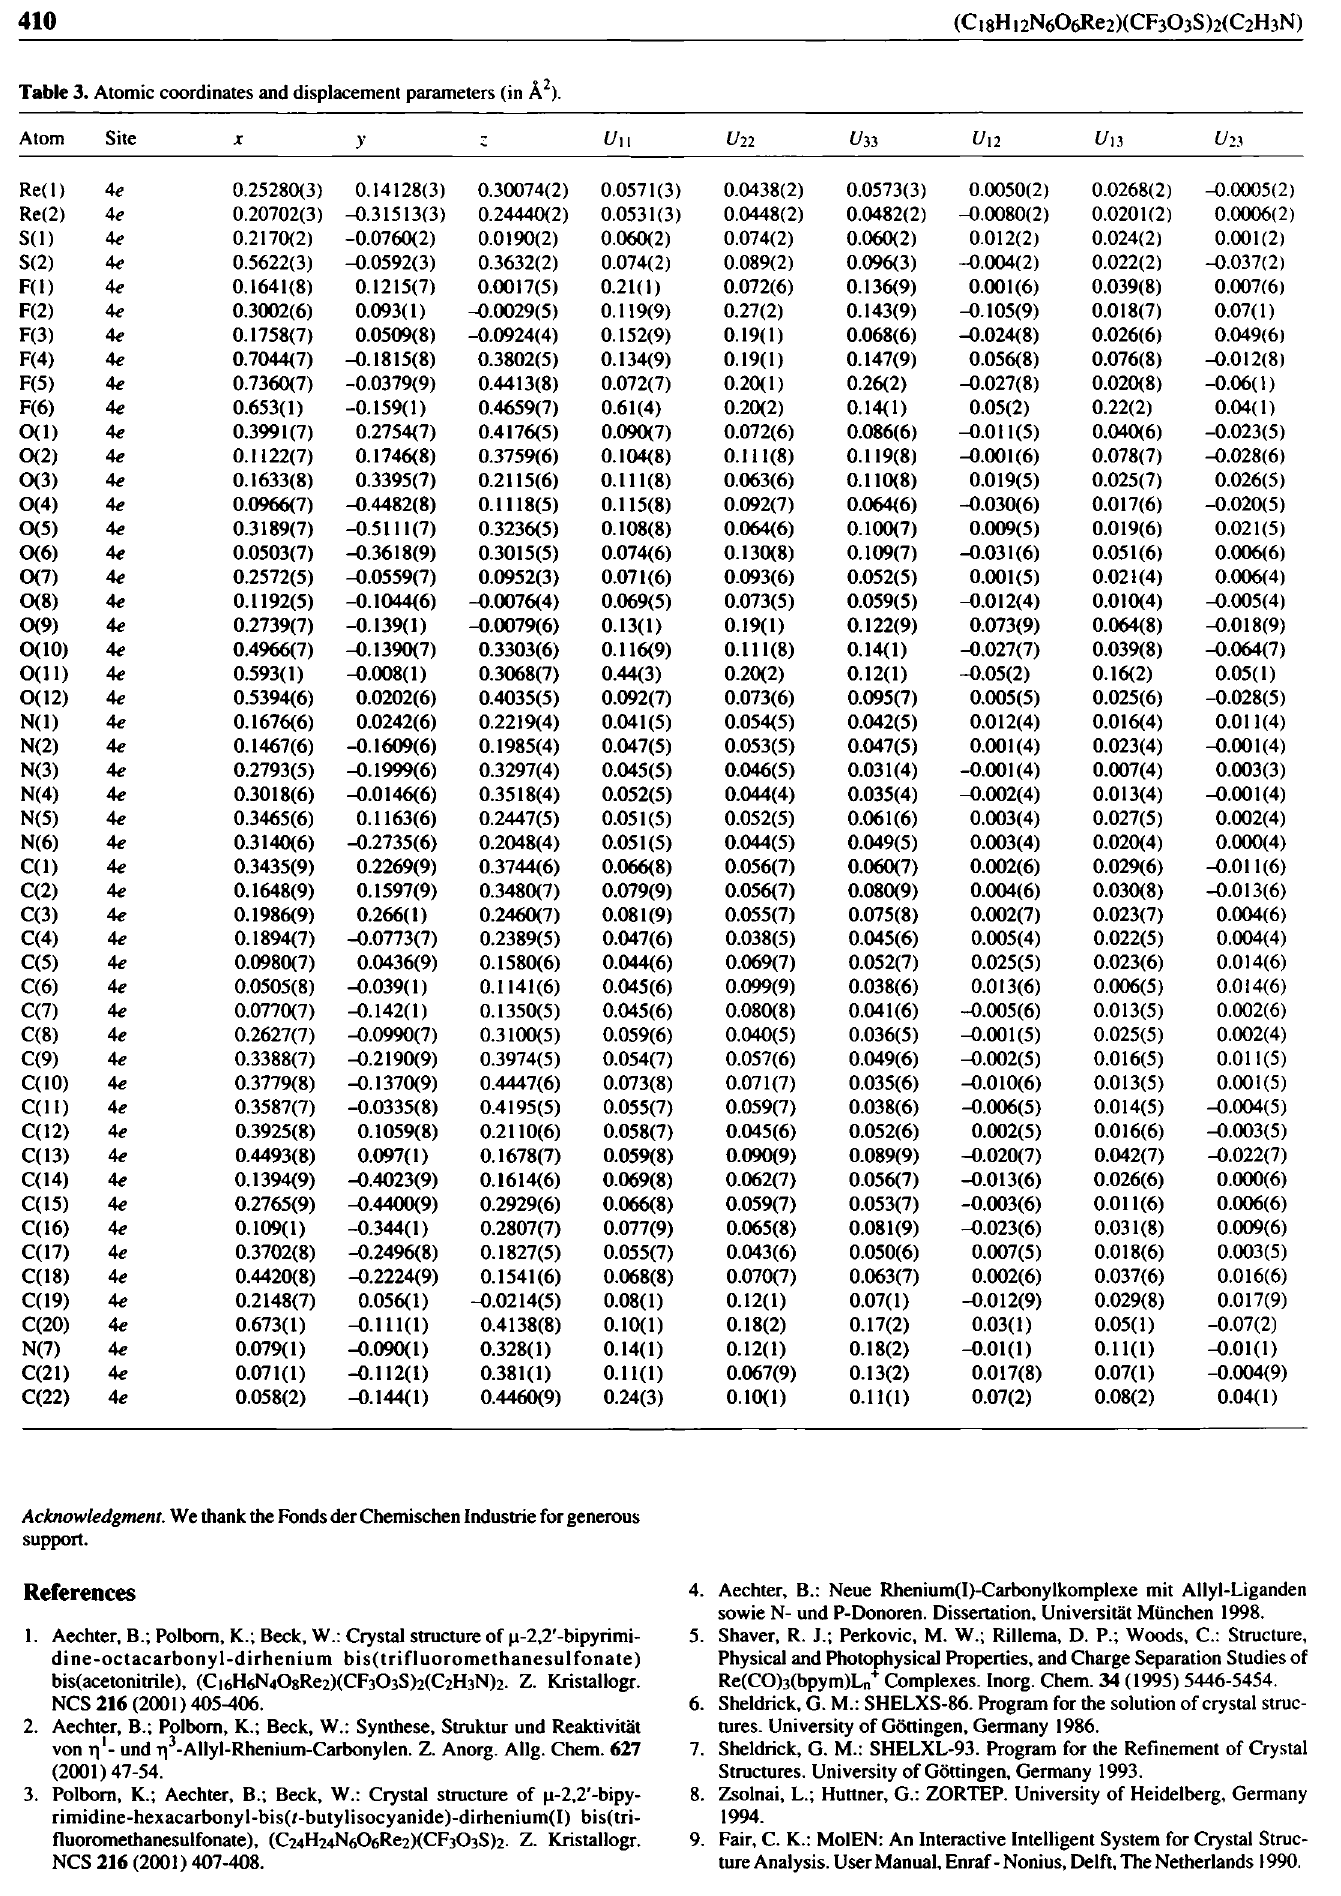
Table 3. Atomic coordinates and displacement parameters (in Ä 2